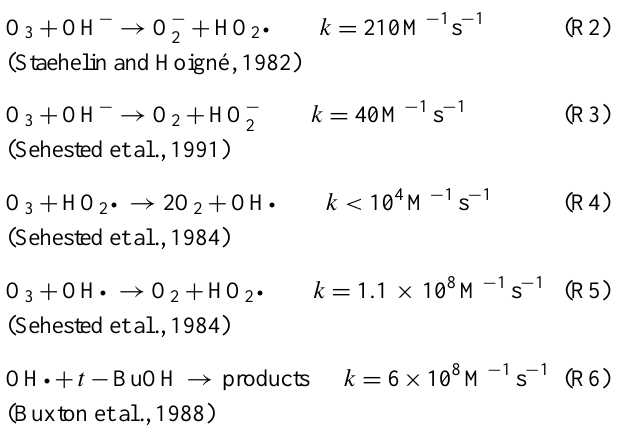
Fig. 1. (A) Absorbance-time profiles of ozone during the reaction with glyoxylate at pH 7. The initial concentration of ozone was about c(O 3 )=5 × 10 − 5 M. (B) Pseudo-first order rate constants k 1st plotted over the concentration of